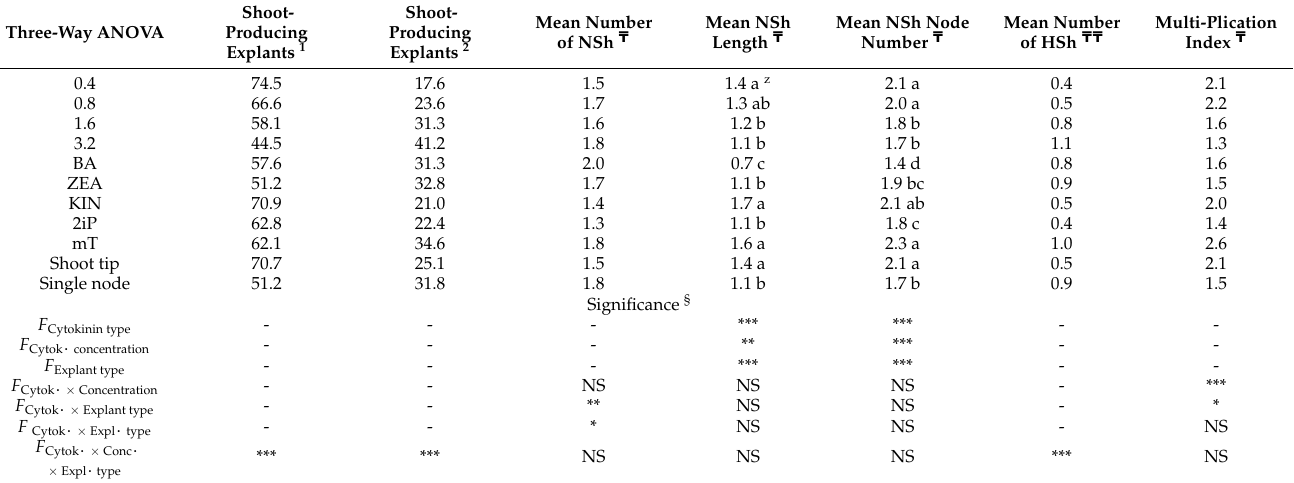
significantly different at p ≤ 0.05. NS: nonsignificant or *, **, *** significant at p ≤ 0.05 or p ≤ 0.01 or p Horticulturae 2023 , 9 , x FOR PEER REVIEW 7 of 32